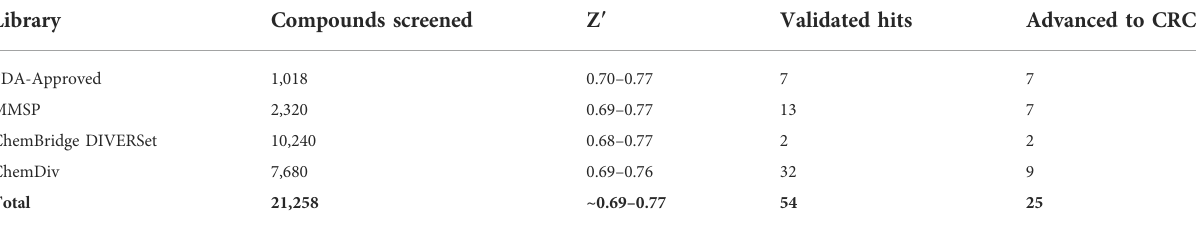
TABLE 2 AC1/CaM FP pilot screen summary. The AC1/Cam FP pilot screen included four chemical libraries. The Z ’ values are the ranges obtained for the designated libraries. A total of 54 validated hits were obtained from the pilot screen and through duplicate hits, unfavorable structures or potency/inhibition pro fi les a total of 25 compounds were advanced for concentration response curve assessment in the AC1/CaM and AC8/CaM FP assays.